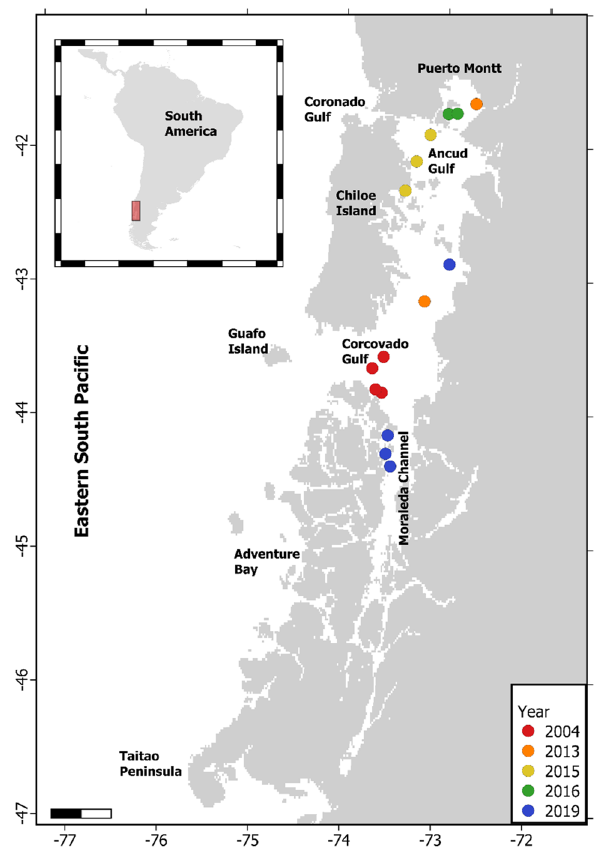
Figure 1. Map of the Chilean Northern Patagonia depicting relevant geographical landmarks, tagging locations and the year of each deployment. Maps were created in R ver. 4.0.2 (https ://www.r-proje ct.org) and ensembled in QGIS ver. 3.8.0 (https ://www.qgis.org) for final rendering. Maps were created using data on bedrock topography from the National Centers for Environmental Information (https ://maps.ngdc.noaa.gov/viewe rs/ grid-extra ct/index .html). Values above 0 were considered land